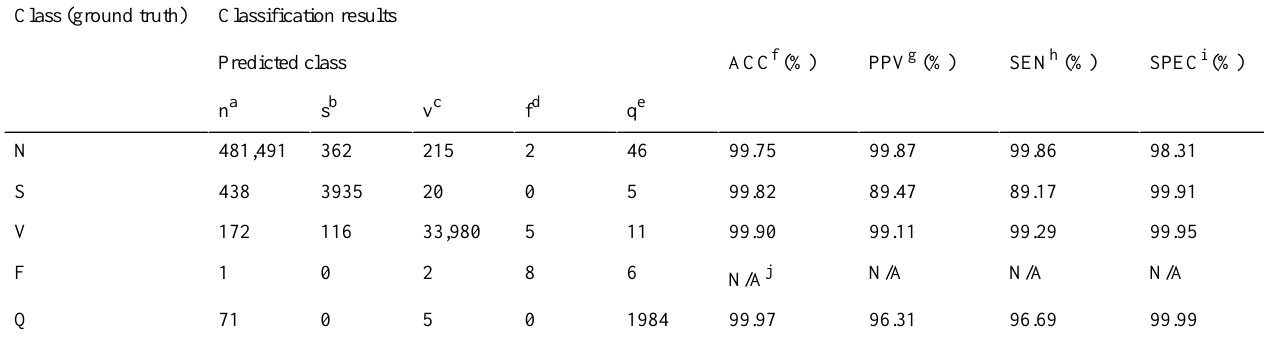
Table 3. A confusion matrix of the baseline model for the test set. Classification resultsClass (ground